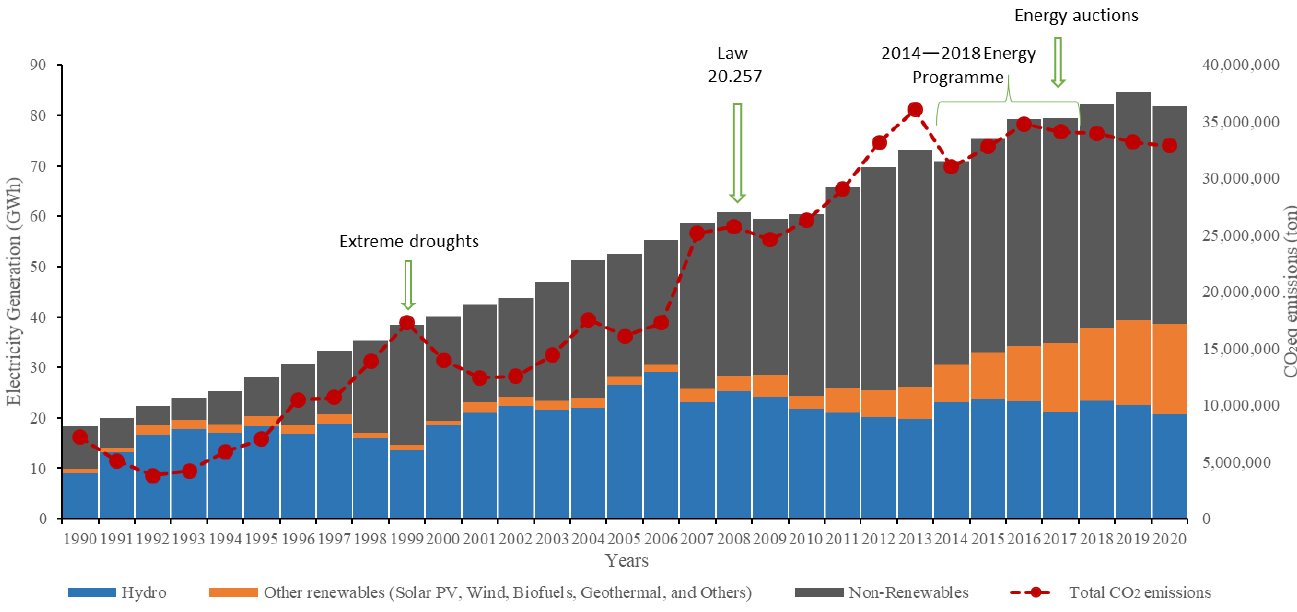
Figure 4. Chile’s electricity generation from renewable (colored scale bars) and non-renewable (grayscale bars) sources and the total CO 2 eq emissions. Source: Elaborated by the authors based on [38 – 40].